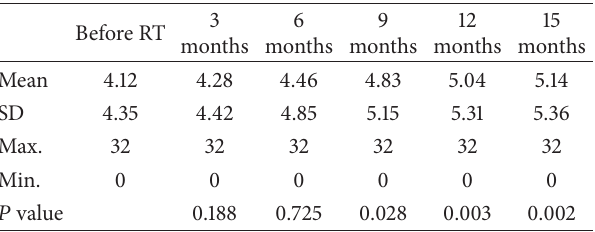
Table 3: Statistical evaluation of